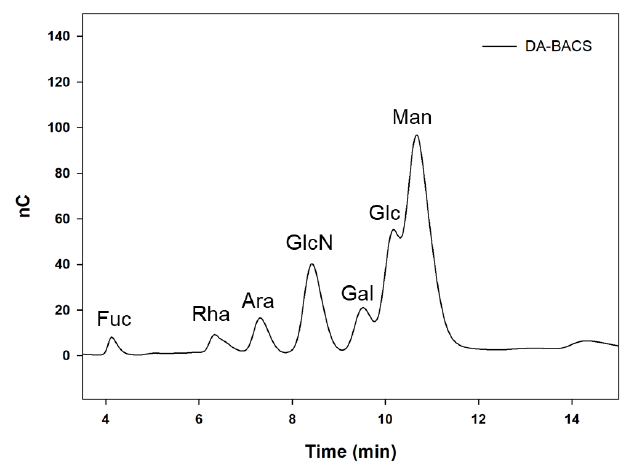
Figure 2. Monosaccharide compositions of EPS produced by L. paracasei EPS DA-BACS. Fuc, fucose;